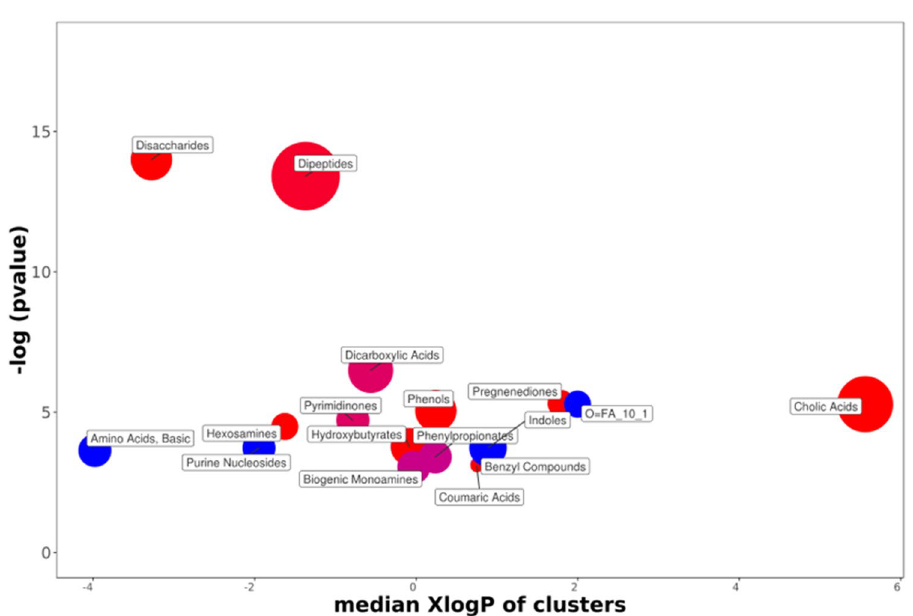
Figure 7. ChemRICH diagram according to the strain resistance. Each disc reflects a significantly altered family of metabolites. These groups are developed from chemical similarities highlighted by a hierarchical Tanimoto map (not shown) accessible in the ChemRICH program. Enrichment p -values are given by the Kolmogorov–Smirnov test. Disc sizes varies with the total number of metabolites. Blue or red discs present groups of overexpressed or underexpressed metabolites in Res compared to Std animals, respectively. Purple color represents both increased and decreased metabolites. For example, there are less disaccharides in the feces of the DCS-resistant